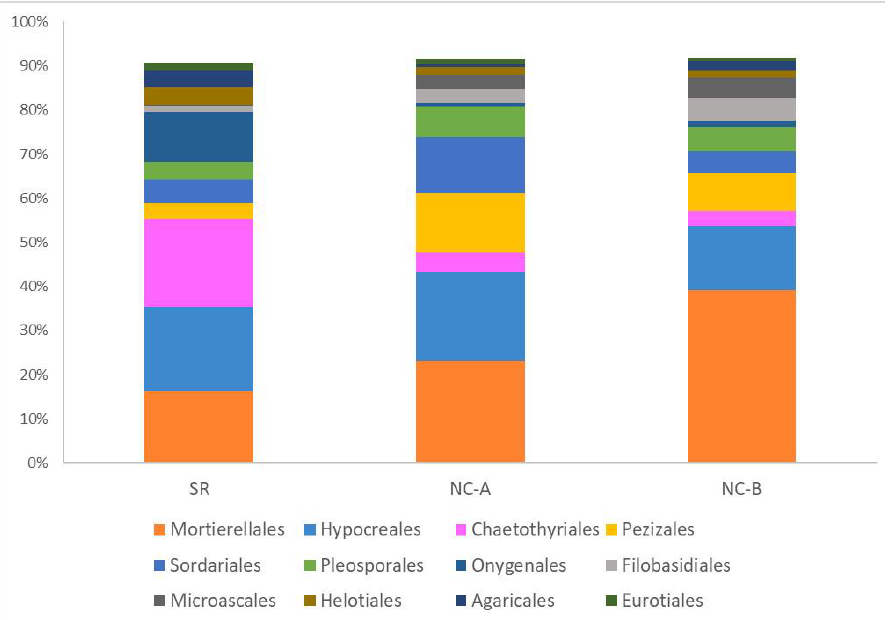
Figure 3. Average soil fungal relative abundances at order level of soil samples taken from Soracá (SR) and Nuevo Colón (steep slope plot at higher altitude: NC-A; flat plot at lower altitude: NC-B). Only the orders with abundances >1% of total reads are plotted in the graph.